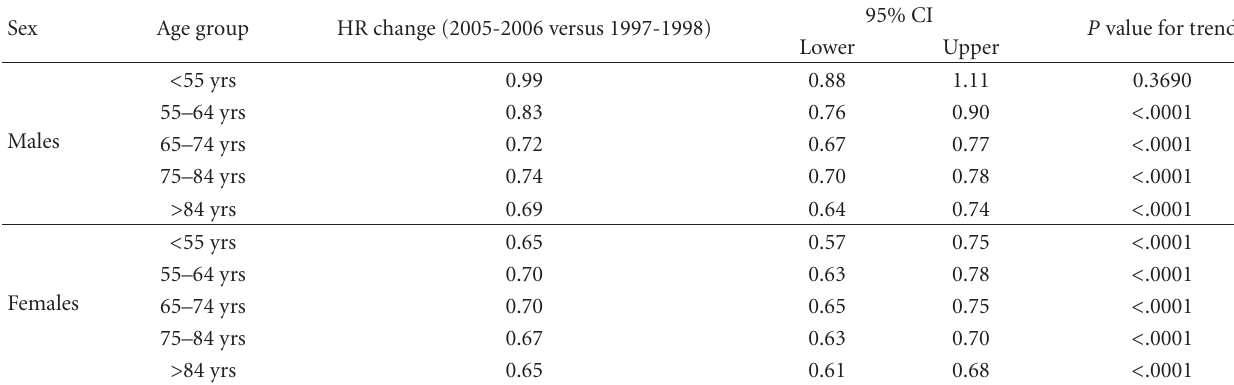
Table 4: In-hospital AMI mortality change across time